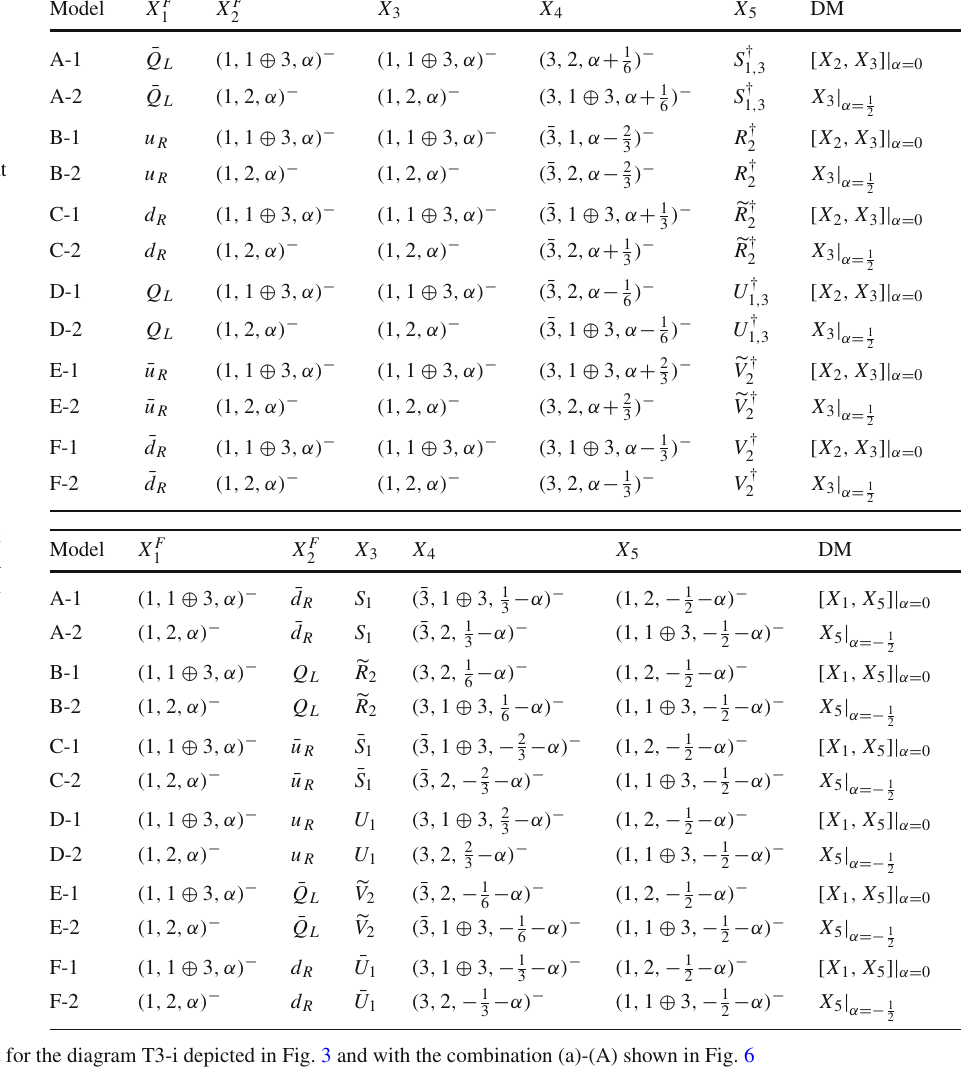
of the quantum numbers under the SU(3) c ⊗ SU ( 2 ) L